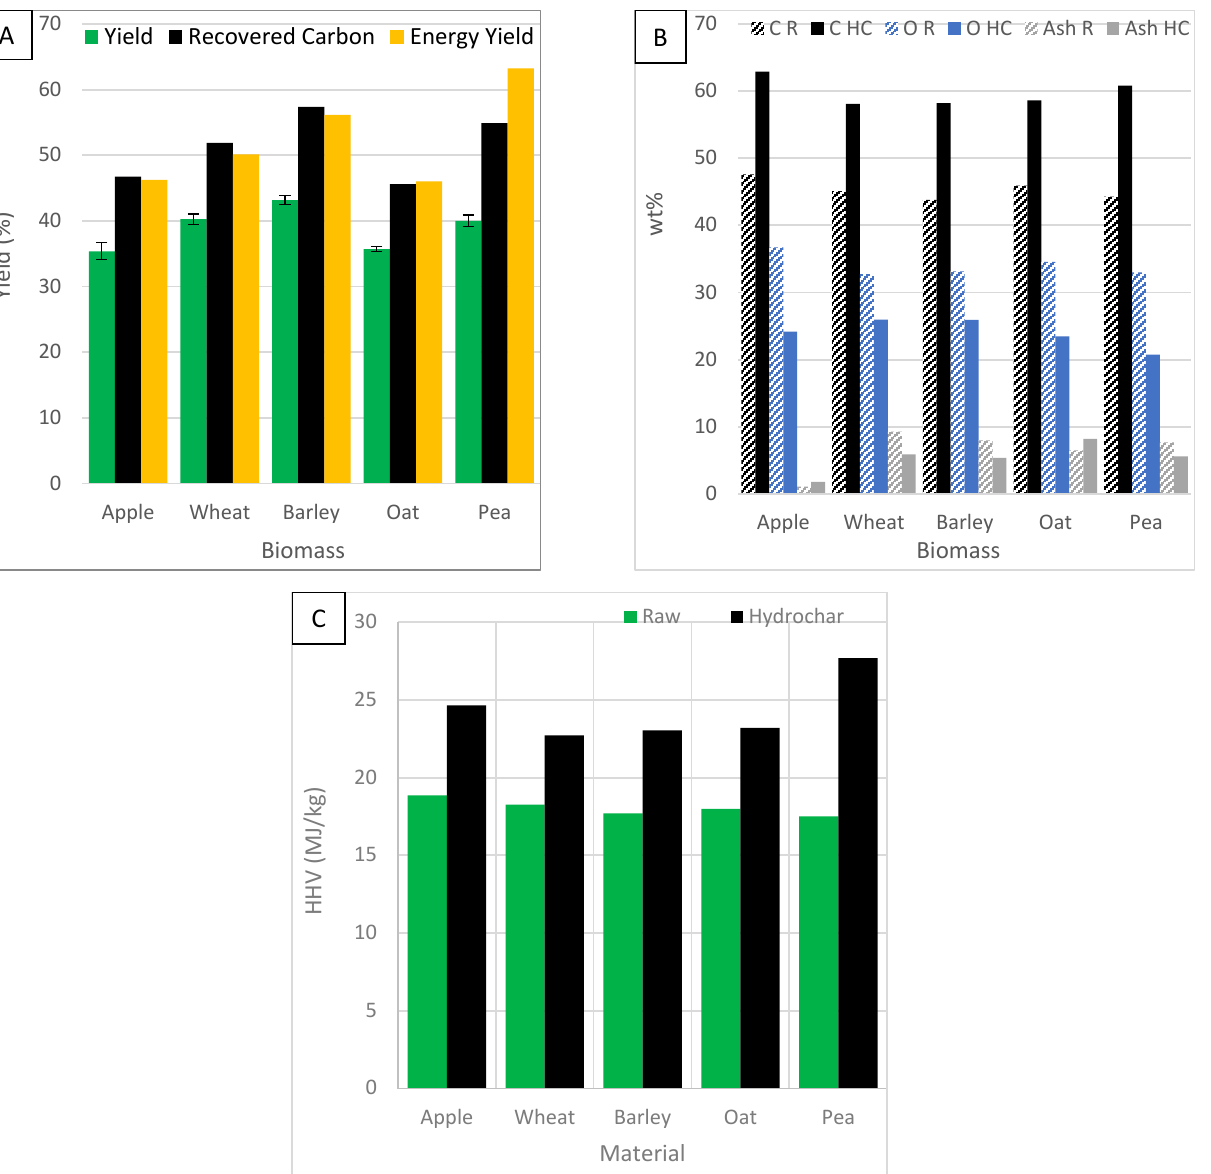
Figure 11. The effect of biomass feedstock on ( A ) yield, carbon recovery and energy yield, ( B ) carbon, oxygen and ash content and ( C ) HHV.